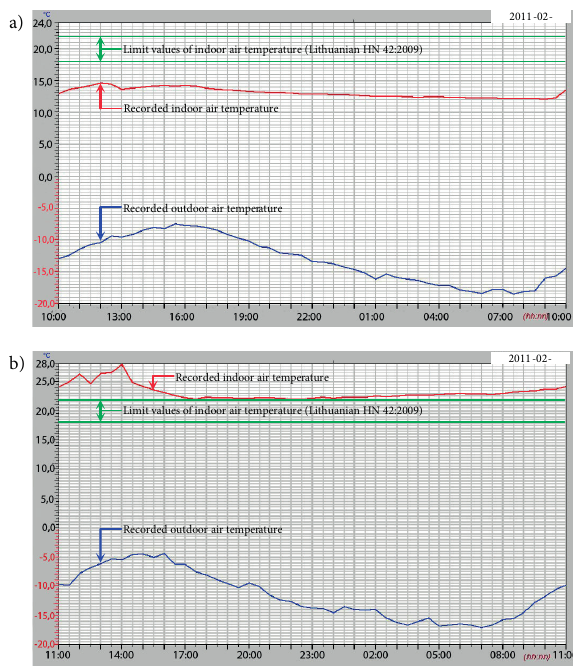
Fig. 1. Outdoor and indoor air temperatures recorded